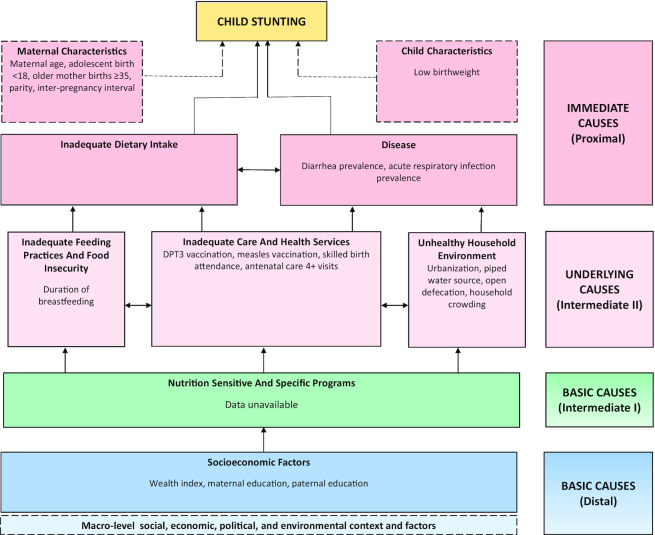
Conceptual framework showing distal, intermediate, and proximal determinants of stunting. Note: Maternal height, maternal BMI, maternal anemia, and vitamin A supplementation have been removed from analyses as these data were not available in all survey rounds, particularly in the DHS 1992/93 and 2017. Complementary feeding and inadequate dietary intake variables (including: minimum dietary diversity, grains, legumes, dairy, flesh foods, eggs, vitamin A–rich fruits and vegetables, other fruit and vegetables) were considered for inclusion, however, were only measured for the 6–23-mo old population; however, this subgroup was not analyzed. The total mean HAZ change for the 6–23-mo age group was too small for our model's results to be meaningful, and analysis resulted in a model with unstable results. Exclusive breastfeeding was also considered for inclusion, however it was only measured for the < 6-mo-old population, which was omitted from analysis due to small sample size. DHS, demographic and health survey; DPT3, diphtheria, pertussis, and tetanus; HAZ, height-for-age z score.